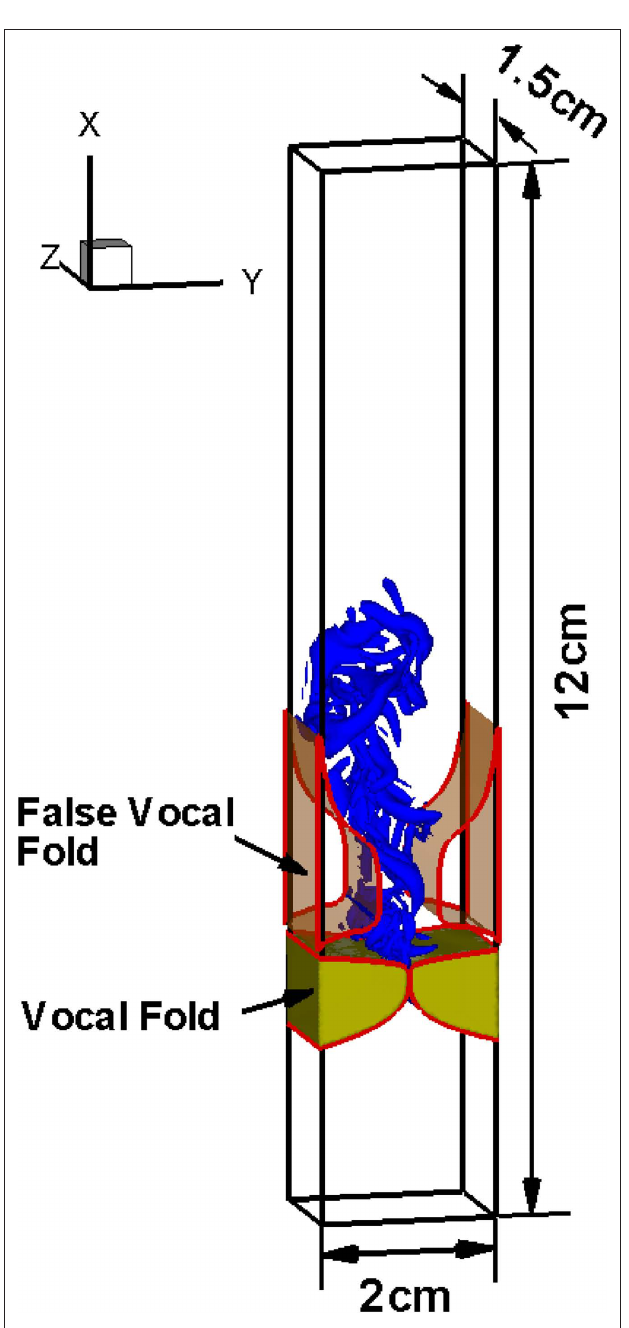
Figure 8 | Computational domain and computed flow structures in a three-dimensional model of the larynx.